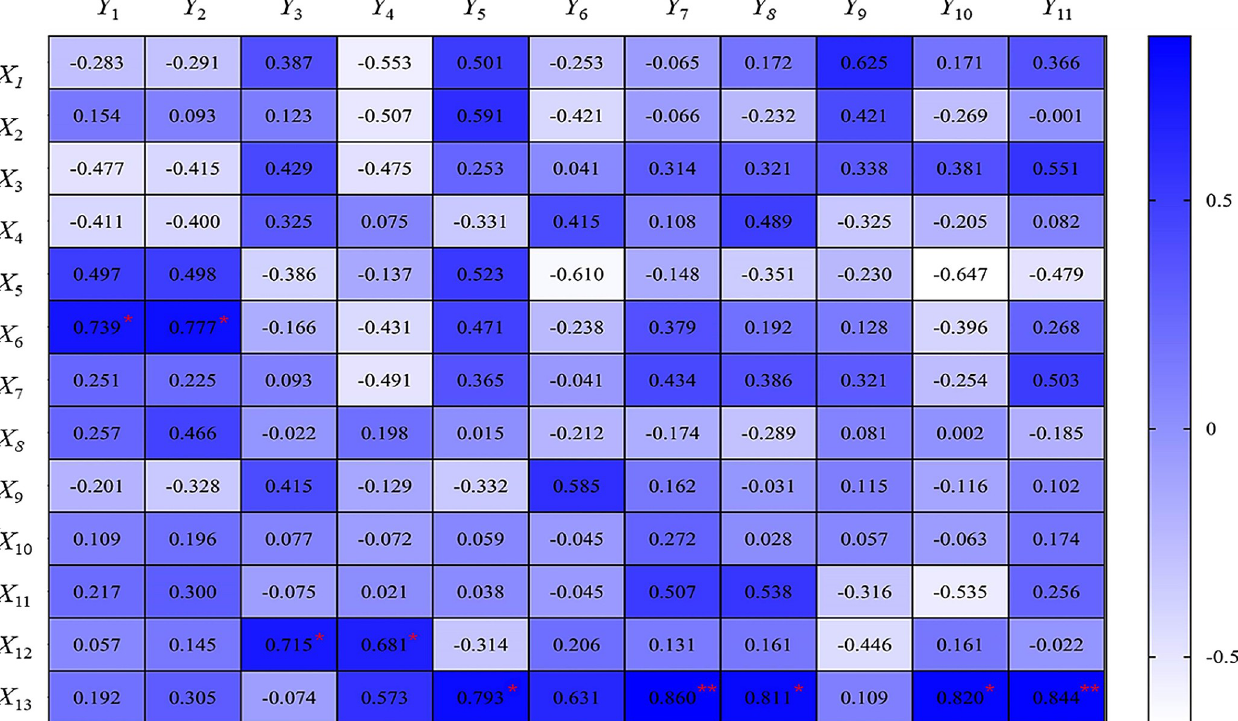
Fig 7. Microstructure of a three-dimensional leaf surface from each sample in atomic force microscope (AFM) view. Alphanumeric identifiers indicate the clone number and upper or lower epidermis of the leaf.